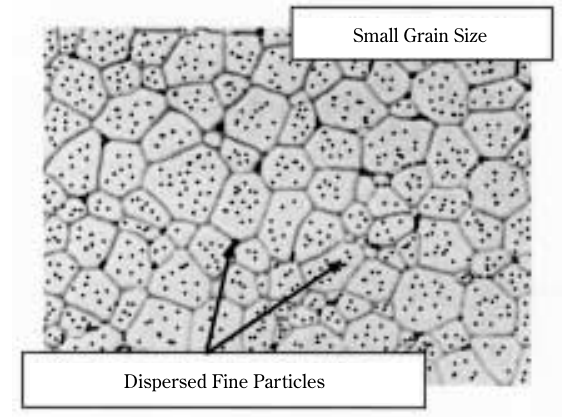
Fig. 1 Ideal microscopic structure for the low κ